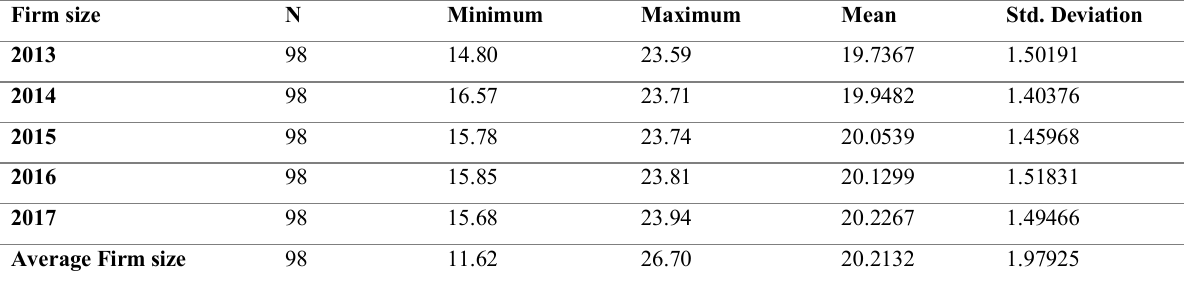
Table 5: Descriptive Statistics for firm size